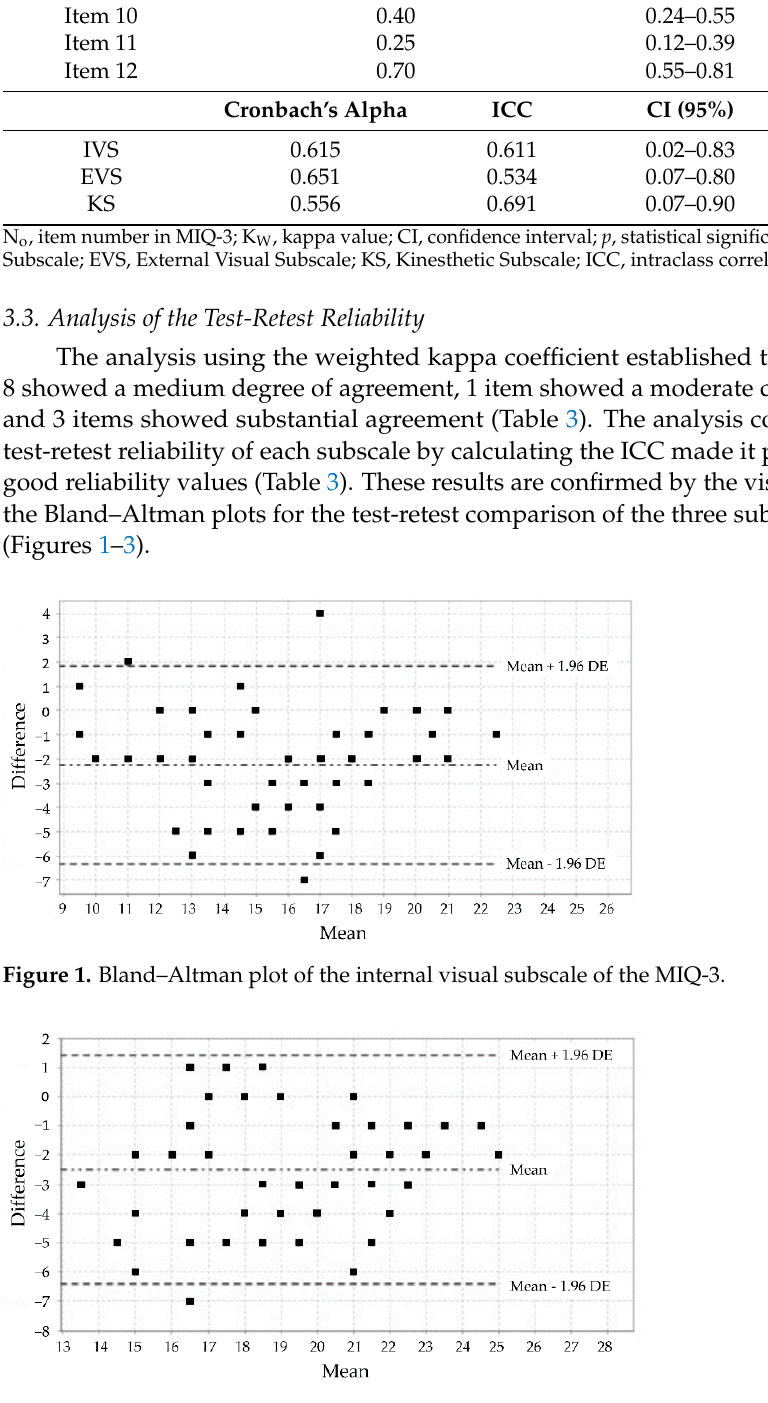
Figure 2. Bland–Altman plot of the external visual subscale of the MIQ-3.